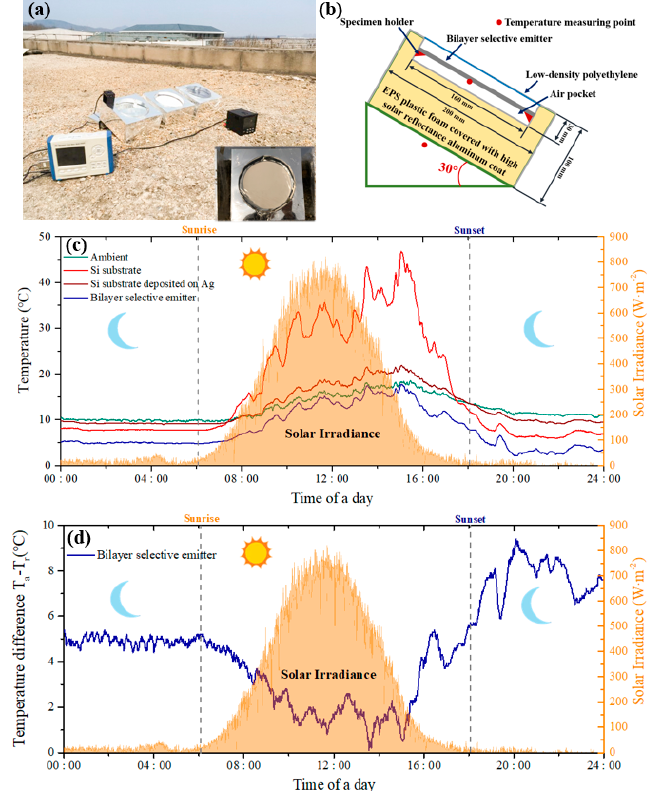
Figure 6. The rooftop measurement apparatus and the results. ( a ) The picture of the testing apparatus. The inset is the picture of a testing box in which the bilayer selective emitter is located. ( b ) The cross section schematic of the testing boxes. ( c ) A 24-h cooling test results of the rooftop measurement. ( d ) The temperature difference between the bilayer selective emitter and the ambient within 24 h.